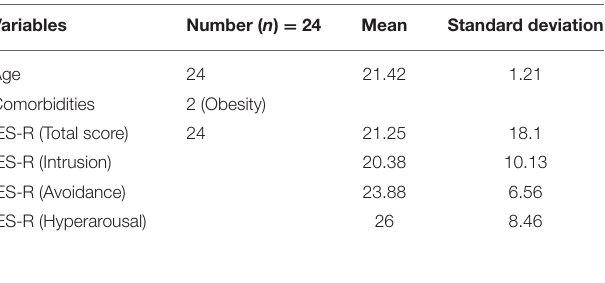
TABLE 1 | Baseline characteristics of the participants in the study.